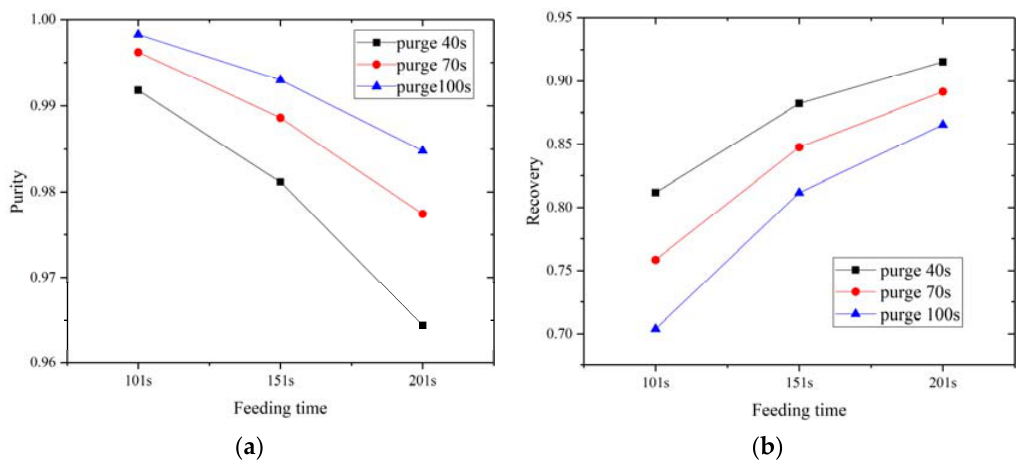
Figure 5. Effects of feeding time and purging time on hydrogen purity ( a ) and recovery ( b ) for VPSA cycles.